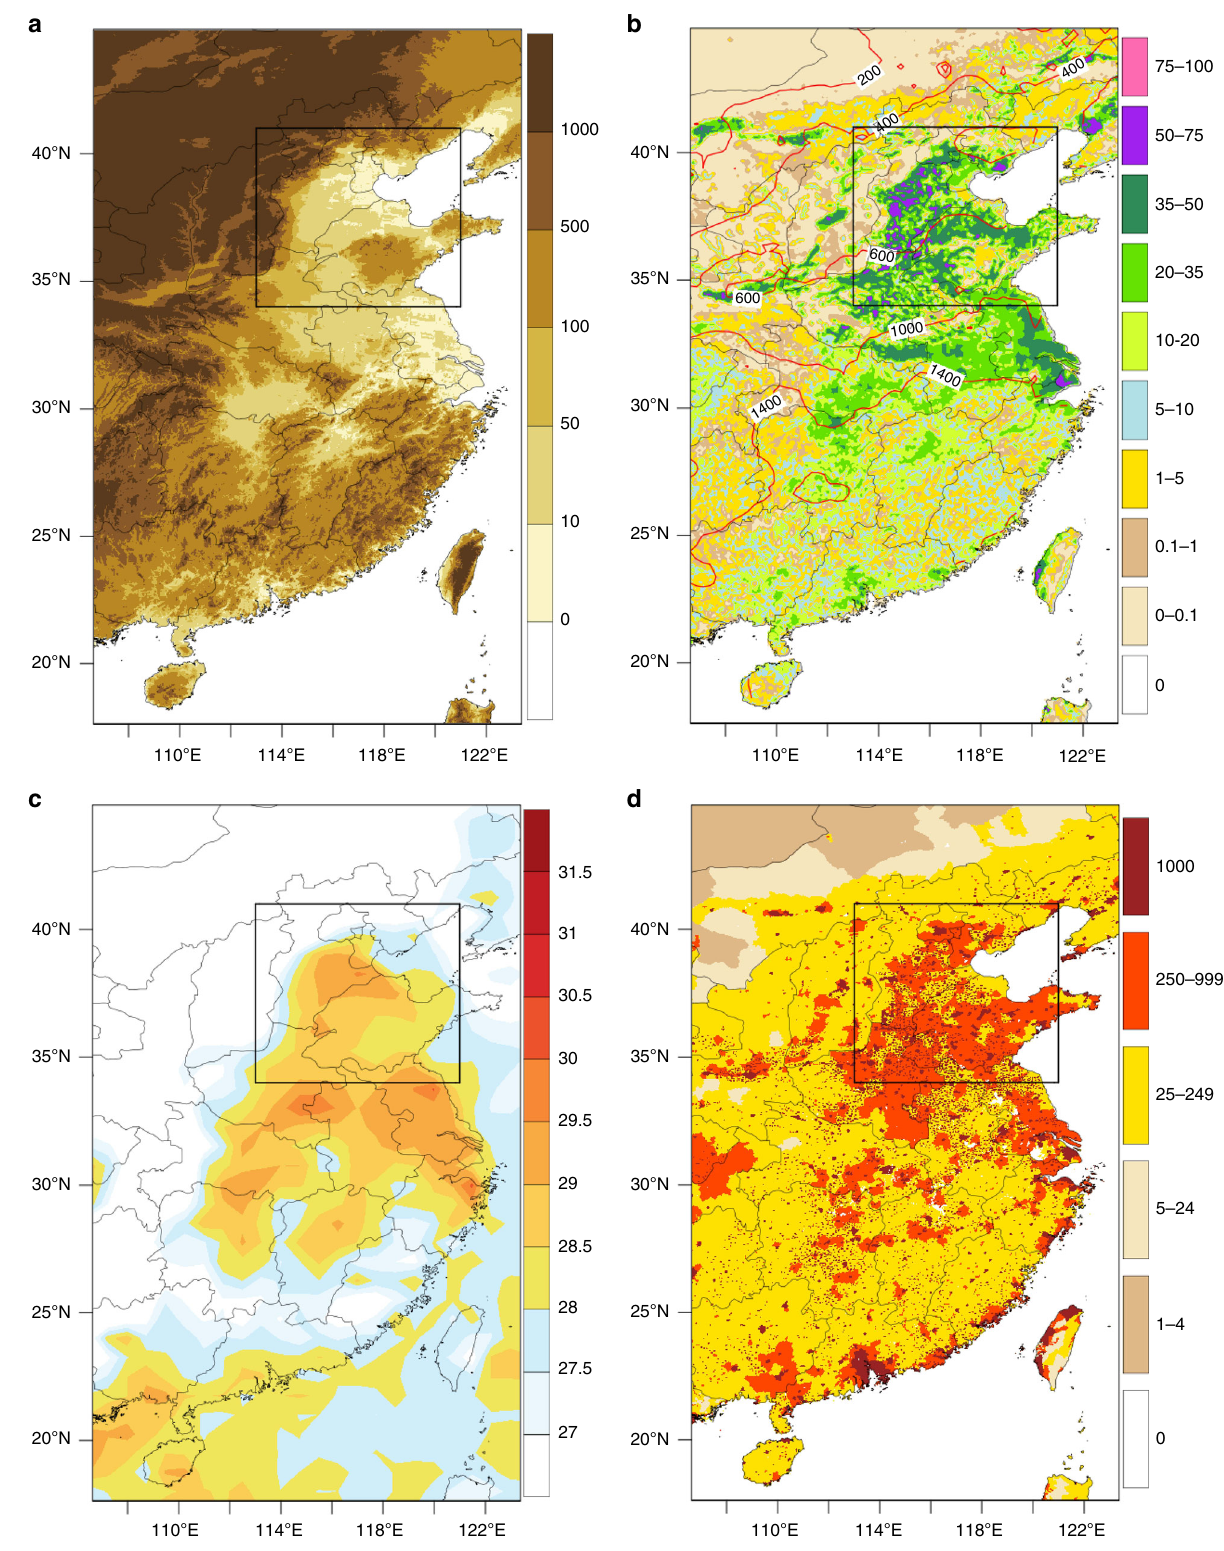
Fig. 1 Brief characterization of Eastern China. Spatial distribution of a topographic map (m), b area equipped for irrigation (AEI, %) for 2005 from Historical Irrigation Data 40 with climatology of annual precipitation from TRMM 49 (contour, mm) in modern record (1998 – 2015), c highest daily maximum wet-bulb temperature from ERA-Interim 41 , TW max (°C) in modern record (1979 – 2016), and d population density 53 in people/km 2 . The box in each plot indicates the North China Plain used for regional analysis in this study. The fi gure was created using the NCAR Command Language